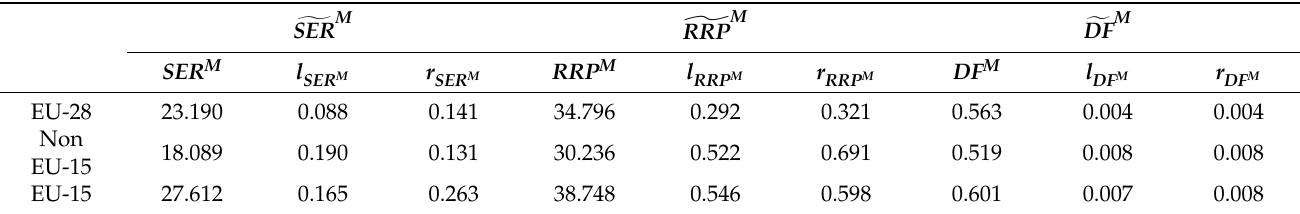
Table 9. Mean values of SER, poverty risk index (RRP) and Debreu–Farrell index (DF) in EU-28, EU-15 and non-EU-15 in the period